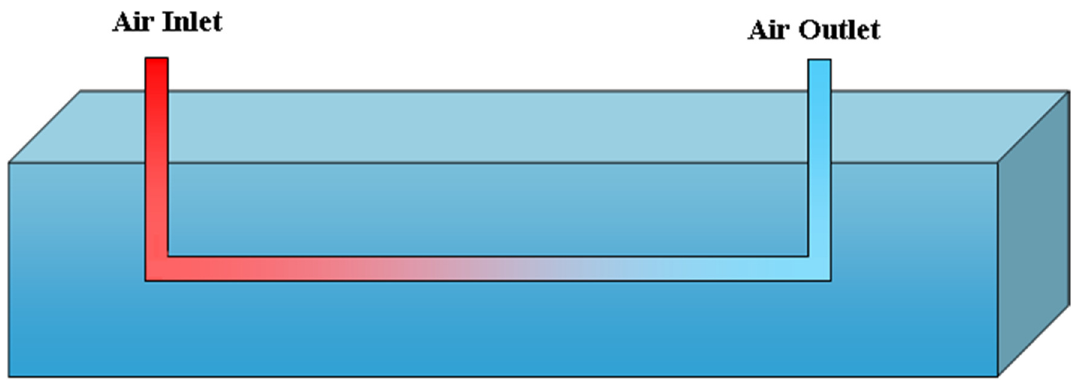
Figure 1. Schematic of Earth-air-heat-exchanger.